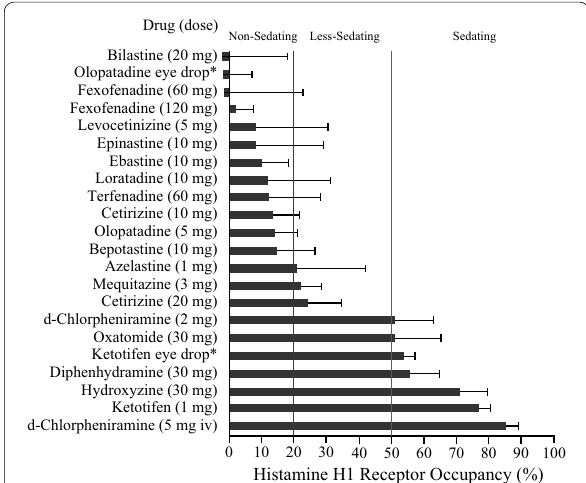
Fig. 1 Brain histamine H 1 receptor occupancies of various antihistamines and classification for sedating actions. The occupancy data are represented as the mean SD of measurements in ± positron emission tomography after oral single-dose, eye drop (*), or intravenous (i.v.) administration of the drugs; the data were obtained by more than one research group. When H 1 receptor occupancy was 20% or lower, the drug could be classified as “non-sedating” (reproduced with permission from